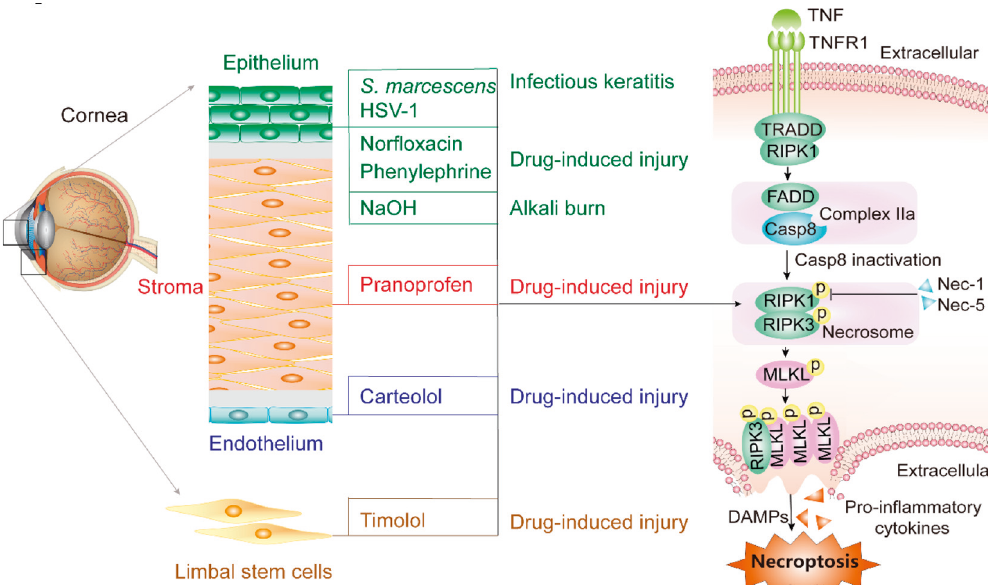
Figure 2: Schematic illustration of the potential contribution of necroptosis to the death of corneal epithelial cells, corneal stromal cells, and corneal endothelial cells. HSV-1, herpes simplex virus 1; TNFR1, TNF receptor 1; TRADD, TNF receptor-associated proteins with a death domain; FADD, Fas-associated death domain protein; Casp, caspase; Nec-1, necrostatin-1; Nec-5, necrostatin-5; DAMPs, damage-as- sociated molecular